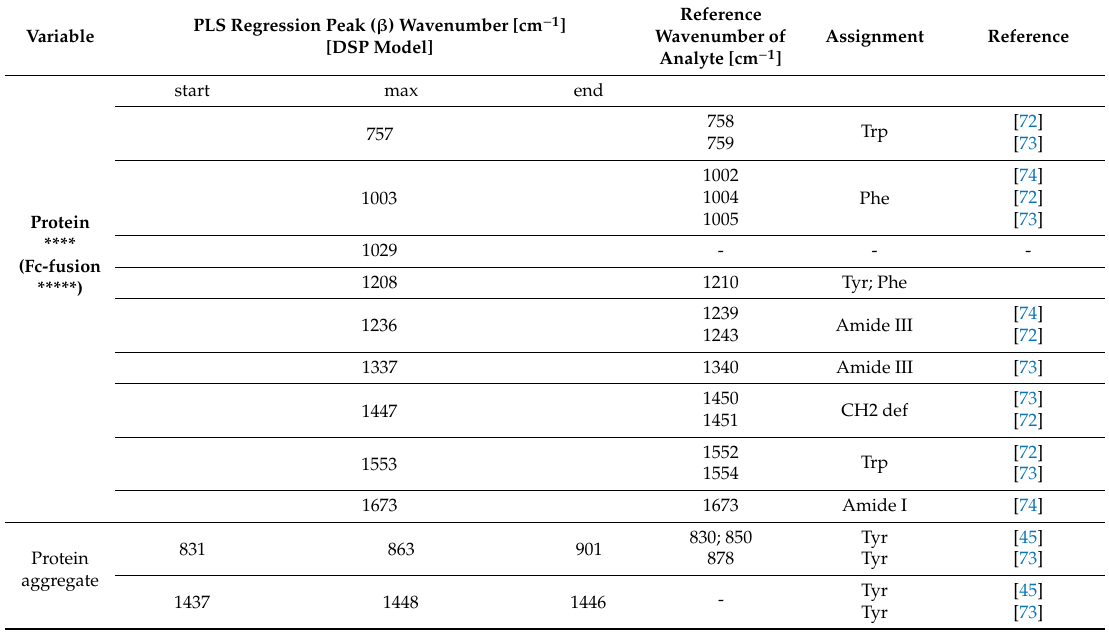
Table 4. PLS dominant regression peaks of protein and IgG aggregates associated with monomer and product concentrations and their corresponding Raman spectroscopy vibrational signatures, based on previous literature values detailing reference wavenumbers for the variables of